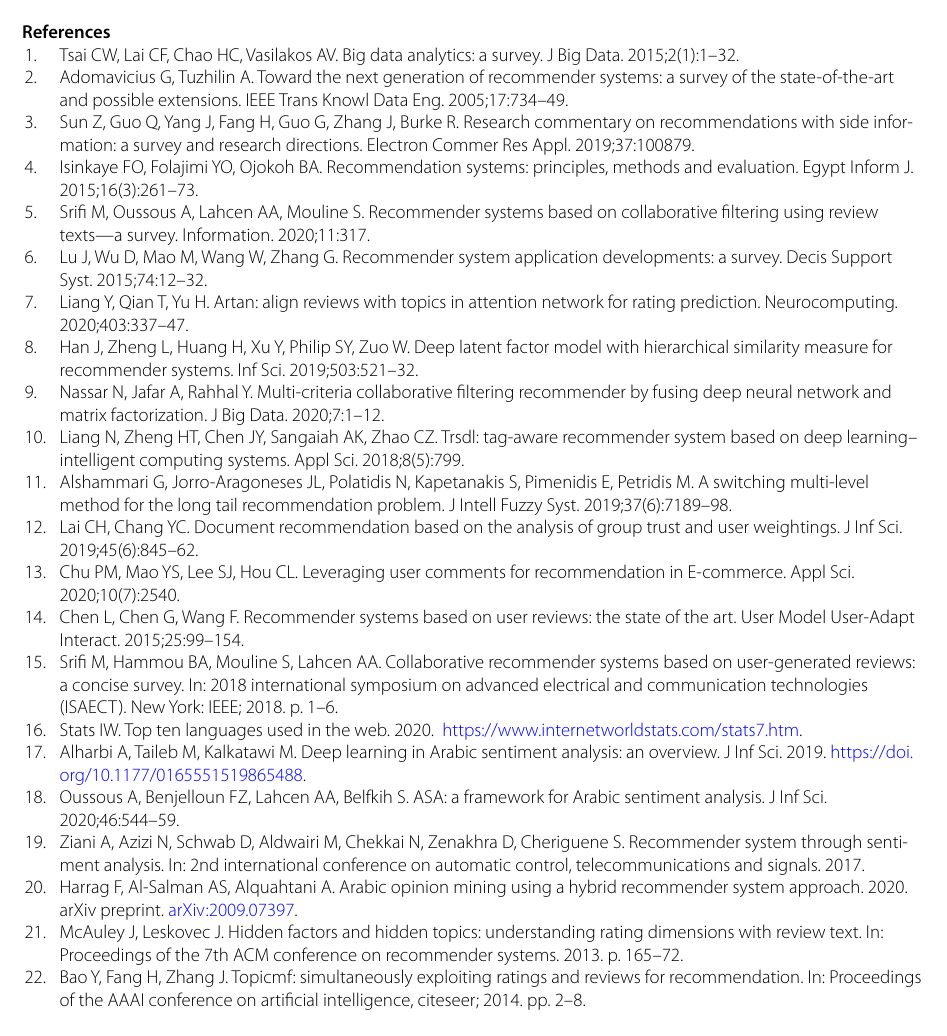
*No-preprocessed dataset